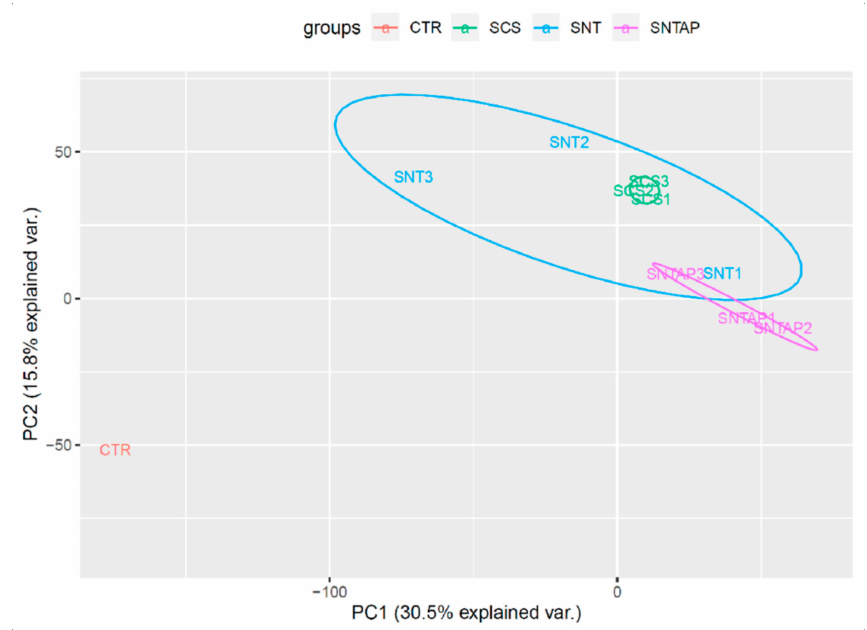
Figure 4. Principal component analysis of r-log normalized gene counts for all porcine kidney samples. Frozen renal cortical sections were used for the RNAseq analysis. RStudio was used to perform the principal component analysis with the full set of r-log normalized gene counts for all samples and to visualize the clustering of samples by group. CTR, control baseline kidney with no DCD injury or preservation treatment ( n = 1). SCS, static cold storage ( n = 3). SNT, subnormothermic perfusion ( n = 3). SNTAP, subnormothermic perfusion with 200 nM AP39 ( n = 3). Numbers following group names denote individual